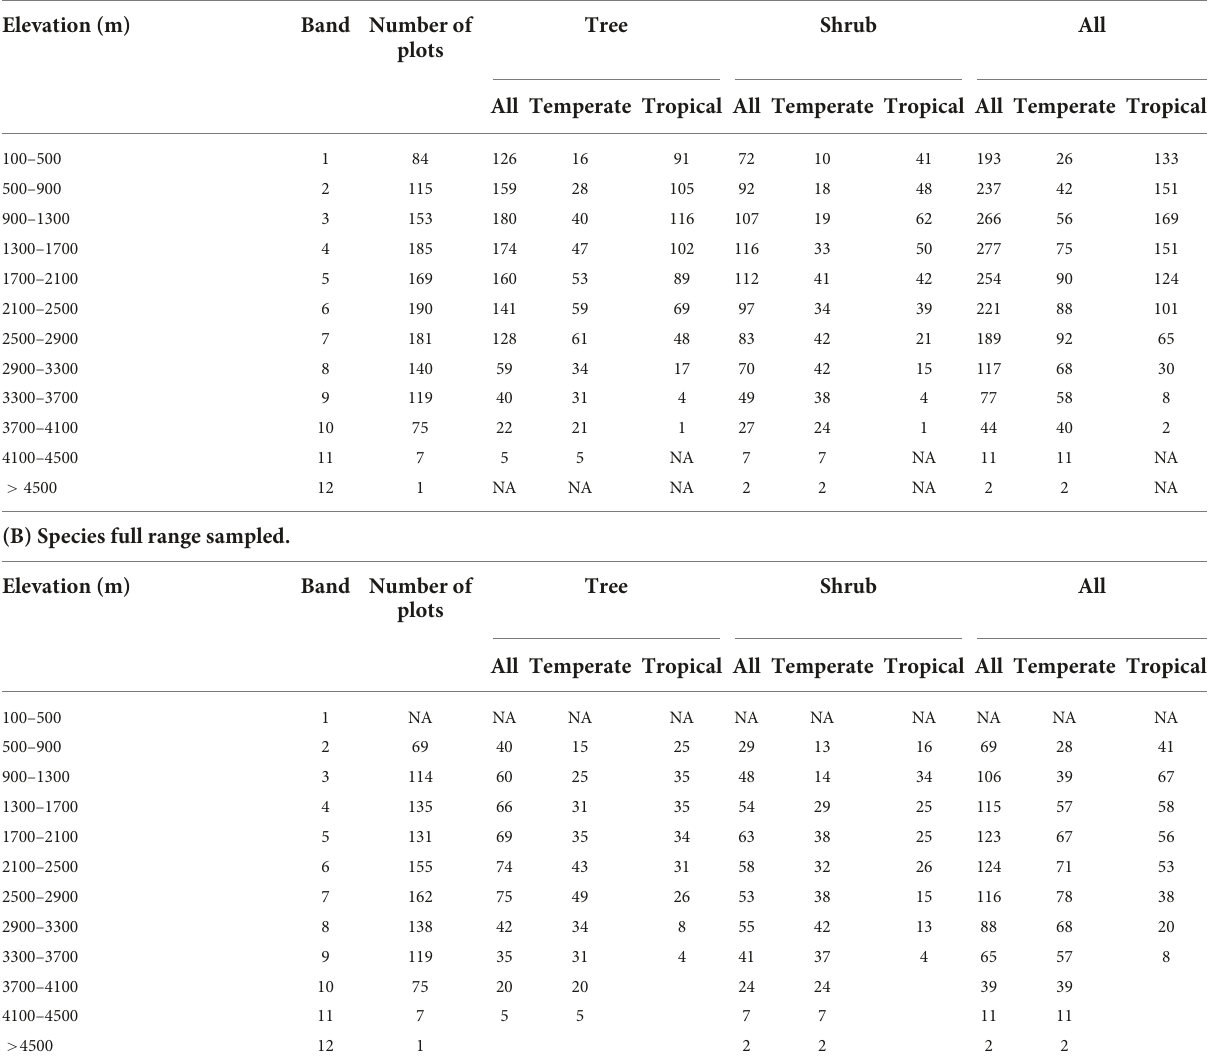
TABLE 1 Species richness of tropical- and temperate-origins for trees, shrubs and combined species, stratified by 400 m elevation bands: (A) for all species analyzed and (B) for only species whose full range was sampled. (A) All